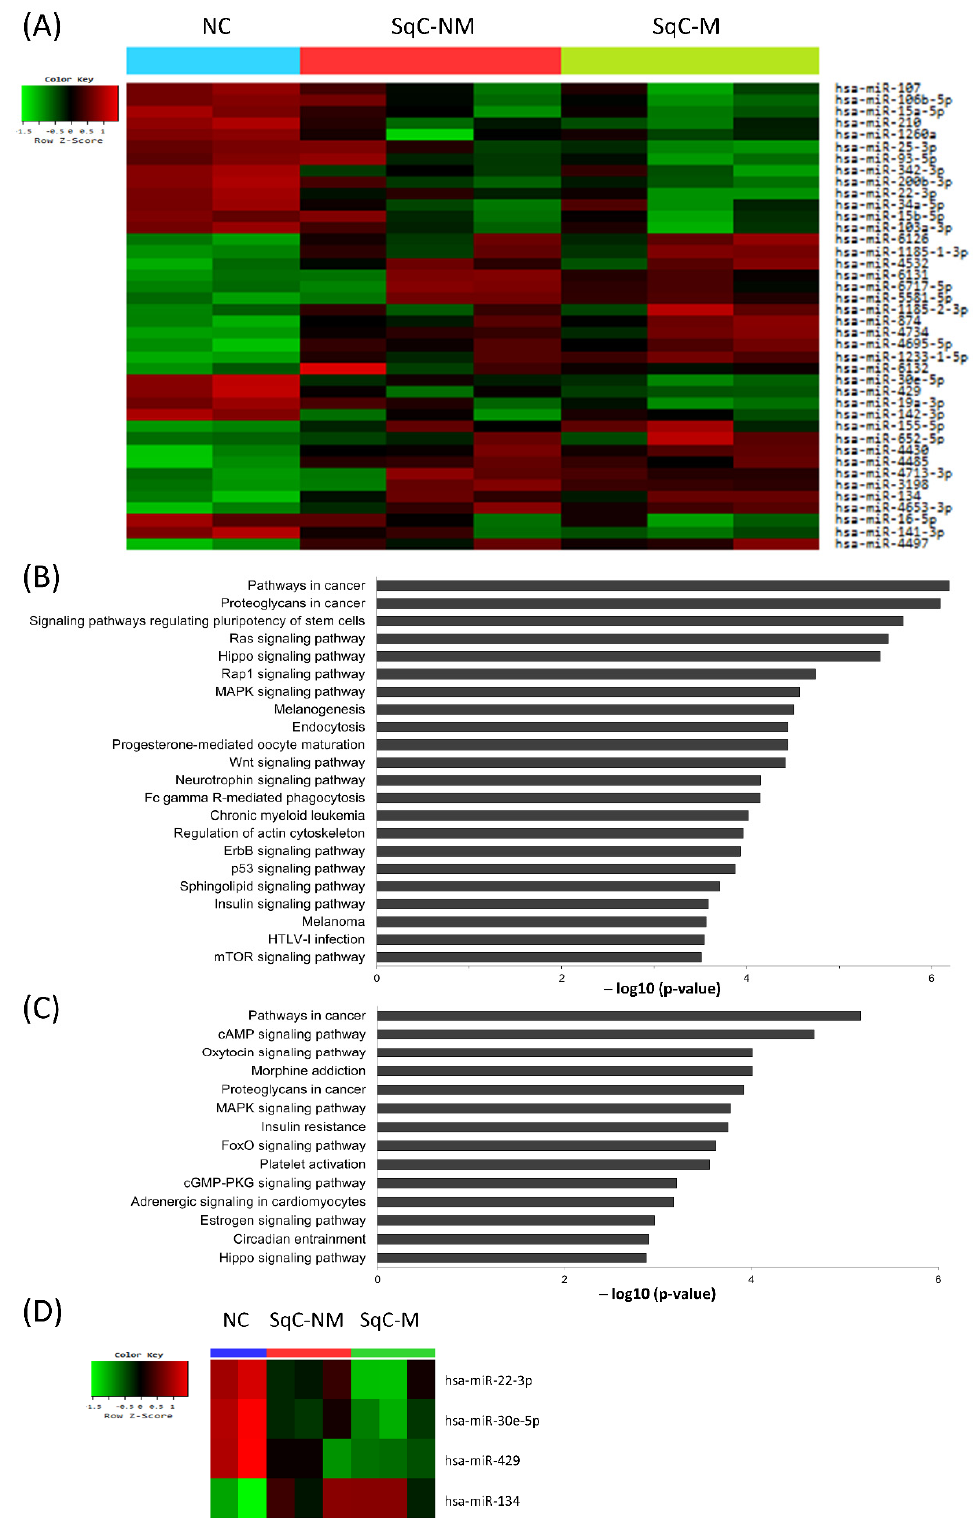
Figure 1. ( A ) Hierarchical clustering of the 40 miRNAs differentially regulated between normal epithelium (n = 2) and cervical squamous cell carcinoma (n = 6). ( B ) KEGG pathway annotation analysis of target genes of the significantly dysregulated 40 miRNAs in 6 cases of cervical SqCC compared with NC, and ( C ) KEGG pathway annotation analysis of target genes of the